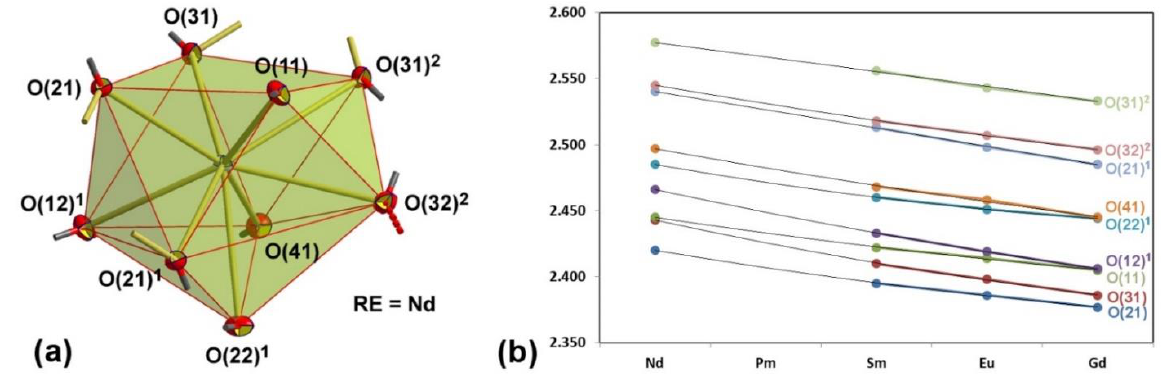
Figure 5. ( a ) Distorted mono-capped square antiprismatic coordination polyhedron of the rare earth atoms in the RE(OAc) 3 · 2AcOH structure type; example RE = Nd. All atoms are drawn as thermal displacement ellipsoids of the 40% level. Bonds from oxygen to carbon are drawn in two colors, bonds from oxygen to neighboring rare earth atoms as short sticks. ( b ) Evaluation of RE-O distances as function of the atomic number of the RE element with trend lines; empty raw of RE = Pm included in order to get an adequate representation; Symmetry codes to generate equivalent atoms: 1 1 − x, 1 − y, 1 − z; 2 − x, 1 − y, 1 −